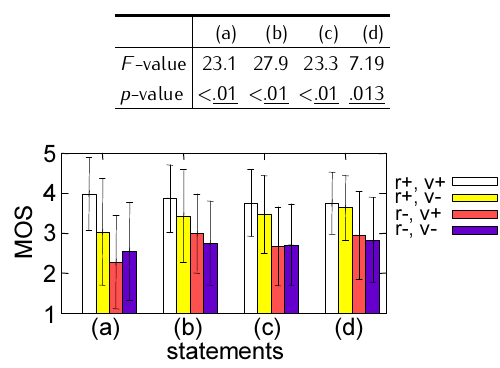
Table 5. ANOVA of Evaluations for Robot’s Existance